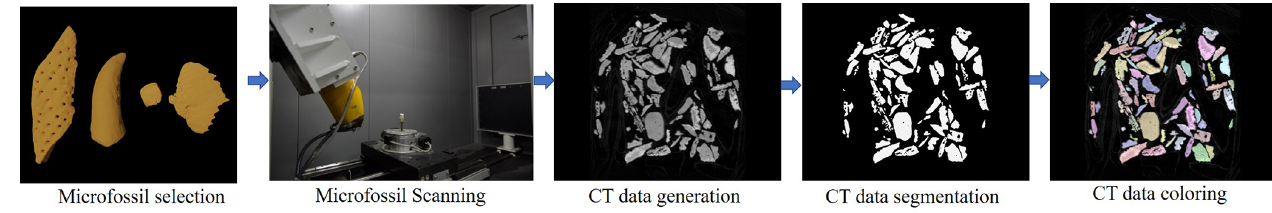
Figure 6. Process of the data preparation.